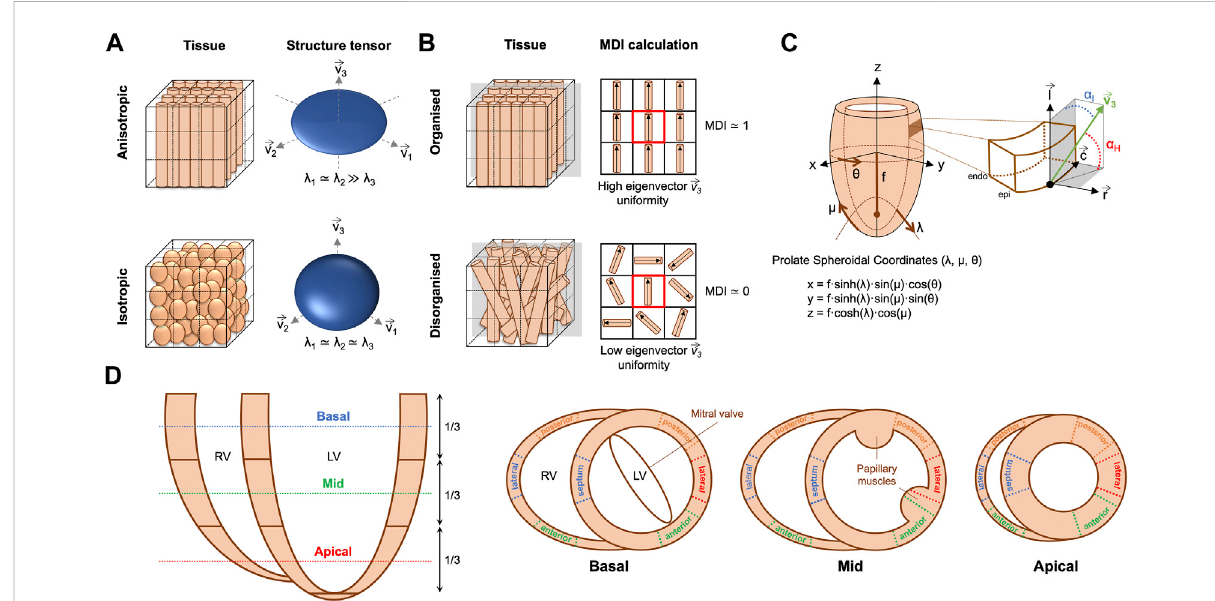
FIGURE 2 (A) Example of anisotropic vs. isotropic myocardium sub-volumes with their corresponding eigenvector system ( (cid:1) v i , i = 1 ... 3) and ellipsoids obtainedwithstructuretensoranalysis,showinghighanisotropyrepresentedbya fl atellipsoidwhenmyocyteshaveamoreelongatedshape,vs.low anisotropy represented by a more spherical ellipsoid, when myocytes have a more spherical shape. (B) Schematic representation of the region of interest (ROI) de fi ned to calculate the structure tensor in a given voxel, formed by the voxel itself (in the centre of the cube — red square in left panel)andtheireightnearestvoxels.Inthisdrawing,eachcylinderrepresentsasinglecardiomyocyte.Therightpanelillustratesthecalculationofthe myocardial disarray index (MDI) in the same ROI used to calculate the structure tensor. In this drawing, we have plotted the tertiary eigenvectors of the 2D plane indicated in grey in therightpanel. MDI in agiven voxel quanti fi es the angular uniformity betweenthe tertiary eigenvectors of the voxel itself (red square) and the tertiary eigenvectors of their nearest neighbours. In an organised myocardium, all the eigenvectors have similar orientations and therefore MDI is close to 1. However, when myocardium is disorganized, all eigenvectors within the ROI have very different orientations, and therefore MDI is close to 0. (C) Scheme de fi ning local prolate spheroidal coordinates of the LV, with transmural ( λ ), longitudinal ( μ ) andcircumferential( θ )axis,andthehelical( α H )andintrusion( α I )anglesusedtodescribemyocyteorientation. α H ,isde fi nedastheanglebetweenthe local short-axis or transverse plane and the tertiary eigenvector (cid:1) v 3 . α I is the angle between the local epicardial tangential plane and the tertiary eigenvector (cid:1) v 3 . (D) Schematic representation of the 2D images slices and LV and RV segments selected to perform the quanti fi cation of myocyte aggregates